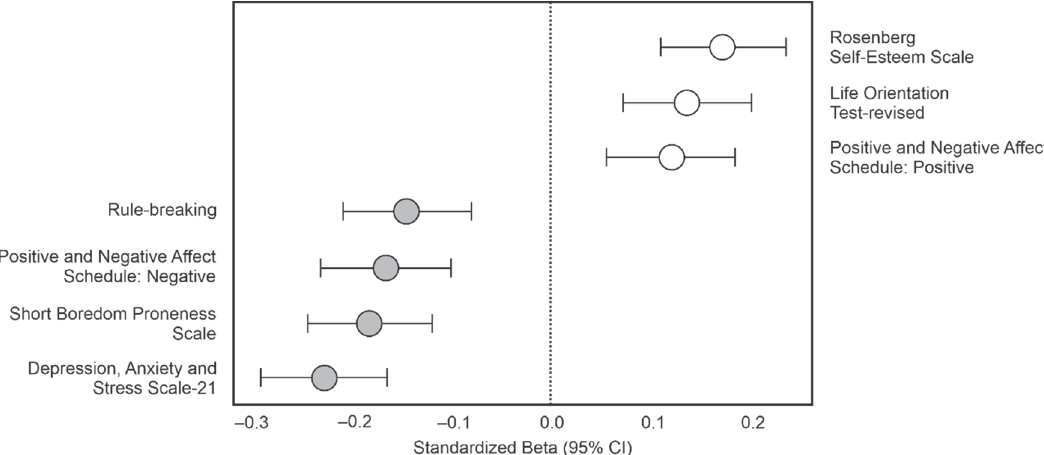
Figure 1 . Standardized beta coefficients from the regression models reported in Table 3. Figure 1. Standardized beta coefficients from the regression models reported in Table